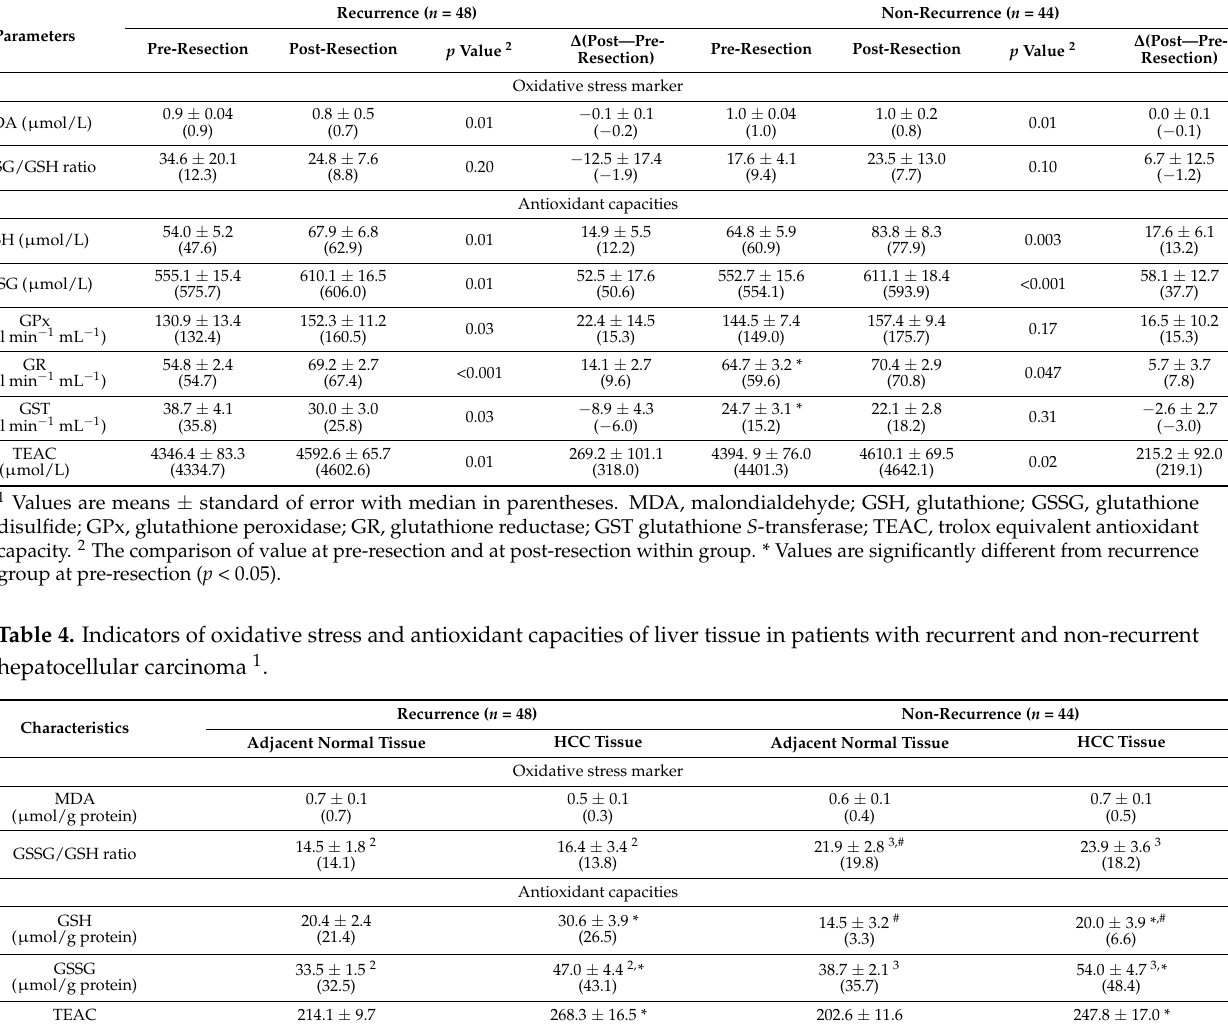
Table 3. Indicators of plasma/serum oxidative stress and antioxidant capacities in patients with recurrent and non-recurrent hepatocellular carcinoma at pre-resection and post-resection 1 .